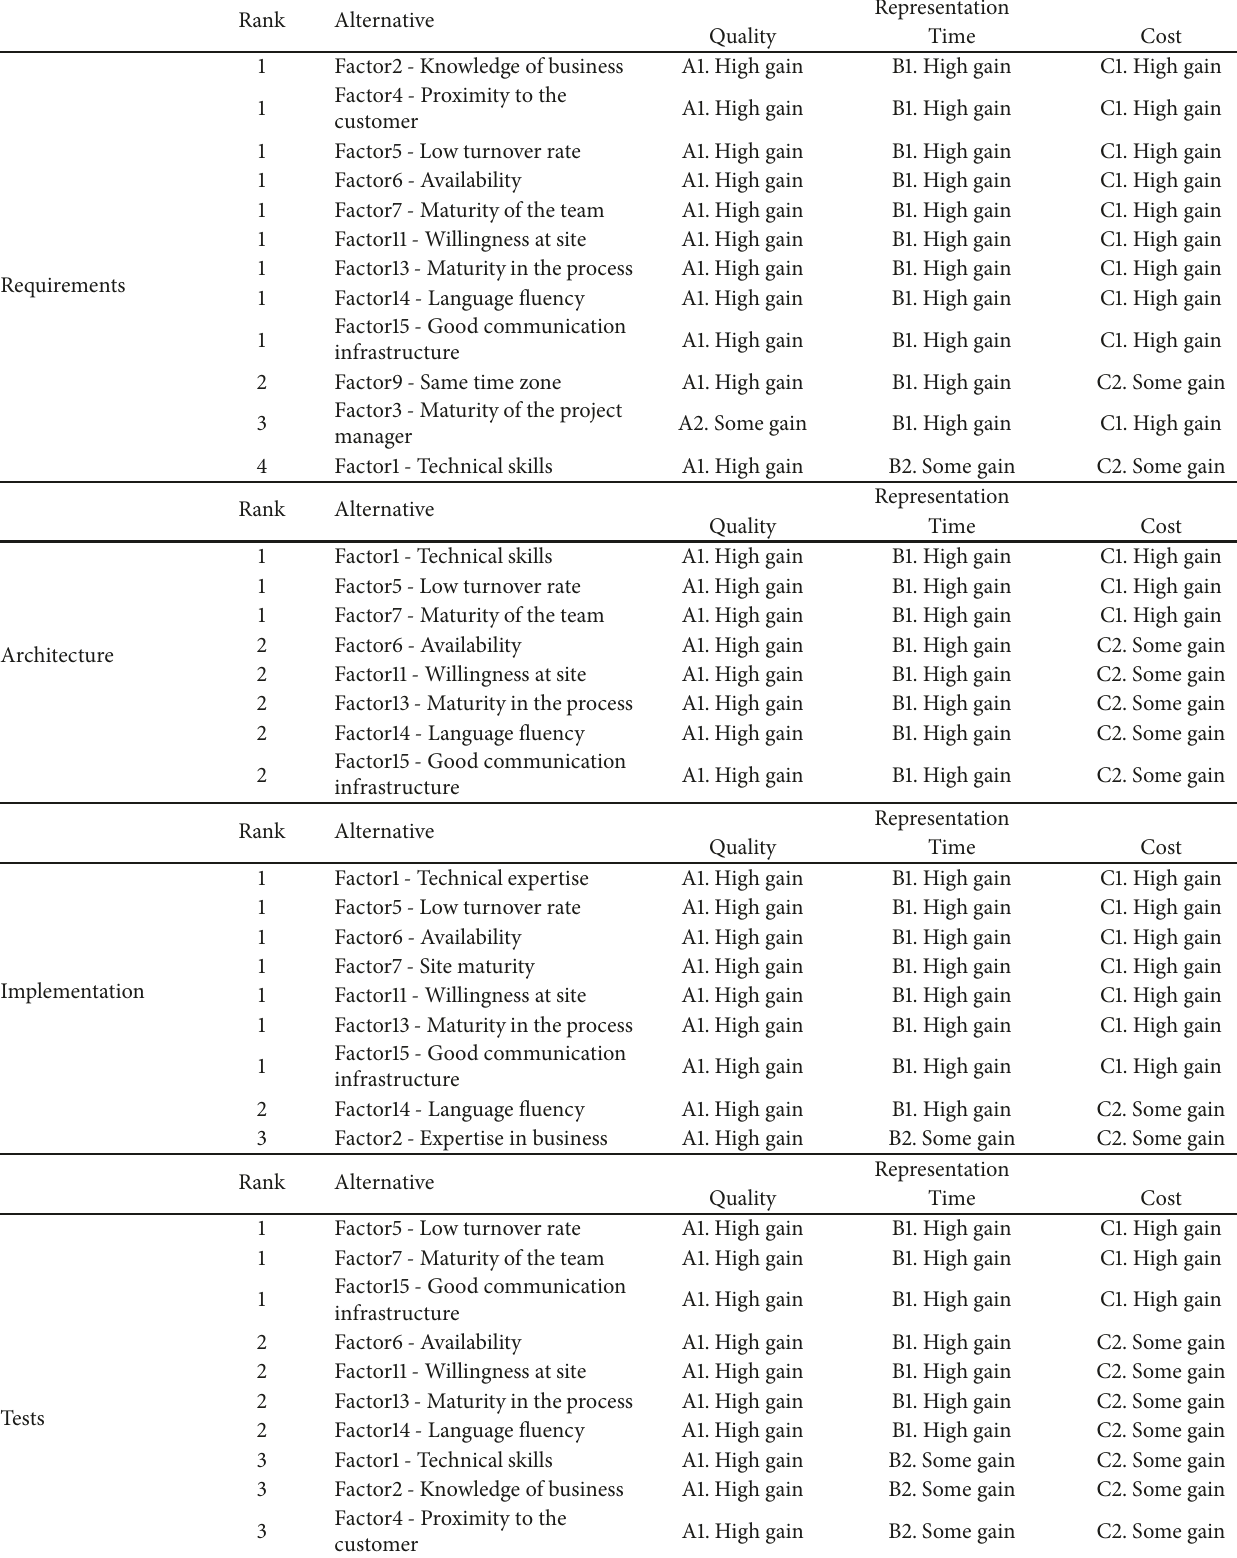
Table 8: Detailed results of ARANA´U application for each type of